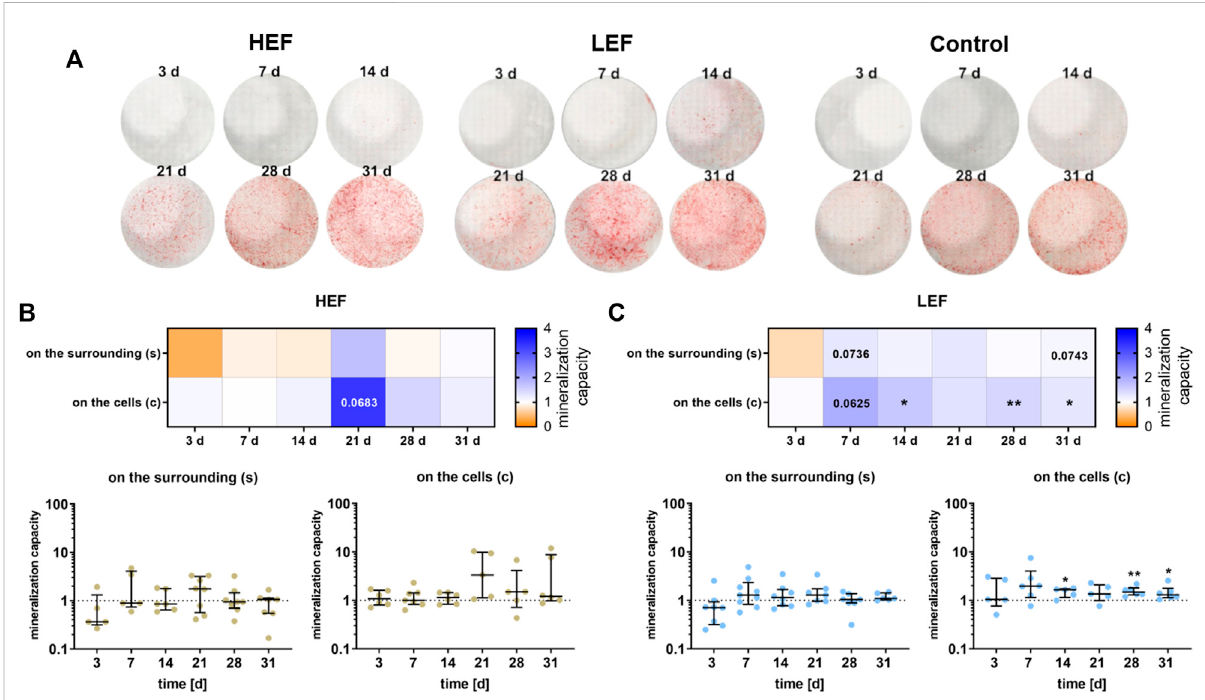
FIGURE 6 Mineralization behavior of human pre-osteoblasts undergoing electrical stimulation. Pre-osteoblasts were stimulated over 31 days with two different electric fi elds (higher electric fi eld: HEF, lower electric fi eld: LEF) and without electrical stimulation (control). Analysis time points were 3, 7, 14,21, 28, and 31 days with assays performed 20 hafter thelast stimulation interval started. (A) Calcium nodule formation on the cellsafter electrical stimulationwithHEF,LEF,andwithoutelectricalstimulationcoloredwithalizarinred. (B,C) EvaluationofthemineralizationbehaviorforHEF (B) and LEF (C) relative to the mineralization behavior of the unstimulated control. The amount of calcium nodule formation was determined after alizarinstainingofthecellsgrownoncoverslips(c)byproportioningthecoloredareastotheuncoloredareasusingImageJ.Theconcentrationofthe calcium deposition on the surrounding (s) was determined after dissolving the mineralized matrix with HCl with the colorimetric Calcium Assay Kit. The unstimulated control of each time point was used for normalization. Results within heatmaps are shown as medians whereby the downregulation is identi fi ed in orange [ < 1], the upregulation in blue [ > 1], and a similar mineralization capacity as the control in white [ = 1]. The distribution of the total results [ n ≥ 5] are depicted as individual values with median and the 25%- and 75%-quartile. * p < 0.05, ** p < 0.01: signi fi cant differences between the stimulated and control